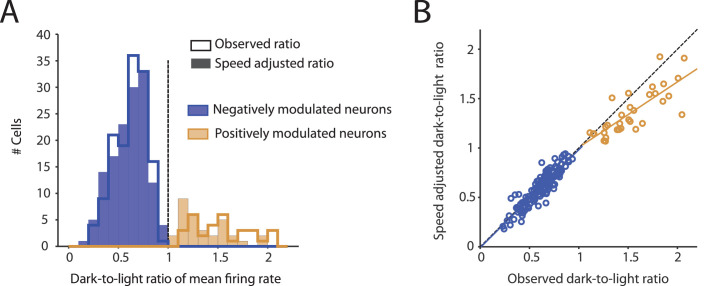
Observed changes in mean firing rates during darkness are not an artifact of changes in running speed.(A) Histograms show the distribution of dark-to-light ratios of mean firing rates of neurons whose firing rates are negatively (blue, n = 139) and positively (ocher, n = 32) modulated by darkness. The step histograms show the dark-to-light ratios computed from the observed firing rates; the filled histograms show the running speed-adjusted dark-to-light ratios. Before running speed adjustment, mean firing rates of negatively and positively modulated neurons were reduced and increased during darkness to 0.62 ± 0.16 and 1.53 ± 0.28 of the firing rates during the light condition, respectively. After running speed adjustment, these values were 0.61 ± 0.17 (mean adjustment = –0.014, CI = [–0.002 –0.026], t = –2.31, df = 138, p=0.023, t-test) and 1.36 ± 0.23 (mean adjustment = –0.174, CI = [–0.112 –0.235], t = –5.78, df = 31, p=2.3×10–6), respectively. (B) Scatter plot showing the strong correlations of the observed dark-to-light ratios of changes in mean firing rates with the running speed-adjusted dark-to-light ratios in negatively modulated neurons (blue, n = 139, R = 0.91, p<1×10–20) and positively modulated neurons (ocher, n = 32, R = 0.79, p=7.9×10–8).